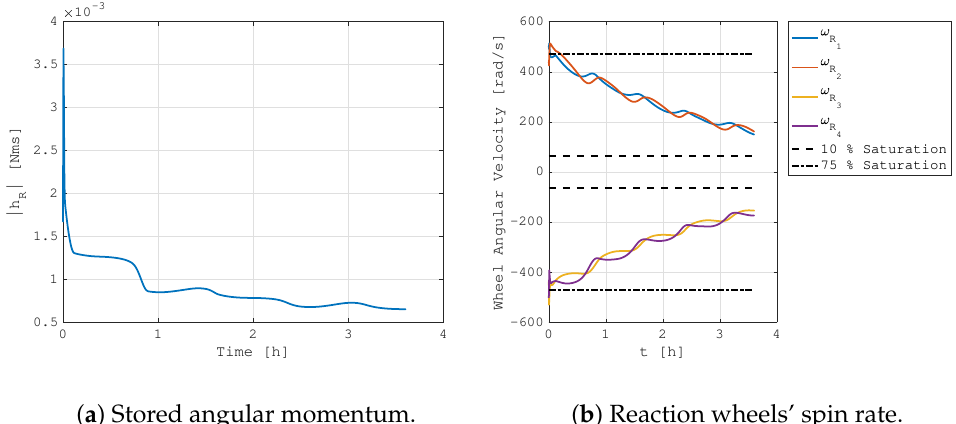
Figure 4. Stored angular momentum evolution in inertial pointing control.